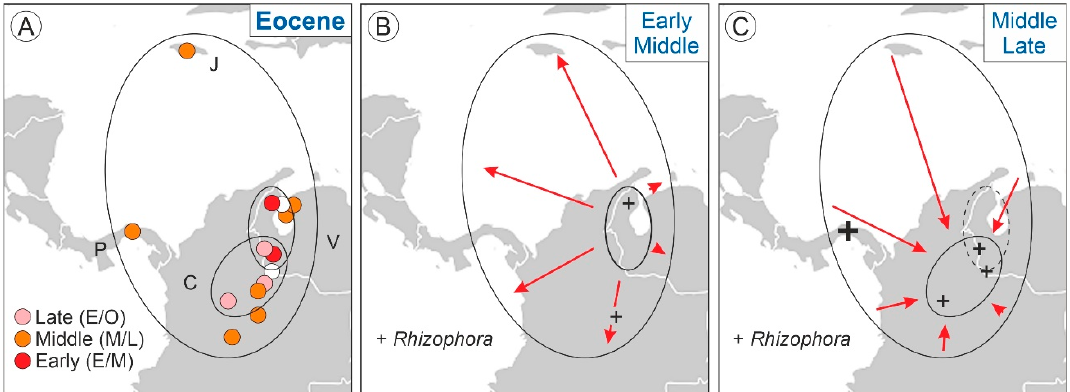
Figure 6. The Eocene expansion–contraction Pelliciera loop. ( A ) Eocene localities (Figure 3) subdivided into Early, Middle and Late Eocene ages (Table S1 of the Supplementary Material). Countries: C, Colombia; J, Jamaica; P, Panama; V, Venezuela. ( B ) Early to Middle Eocene expansion. ( C ) Middle to Late Eocene contraction. The initial Early Eocene range ( A ) is indicated by a broken line.